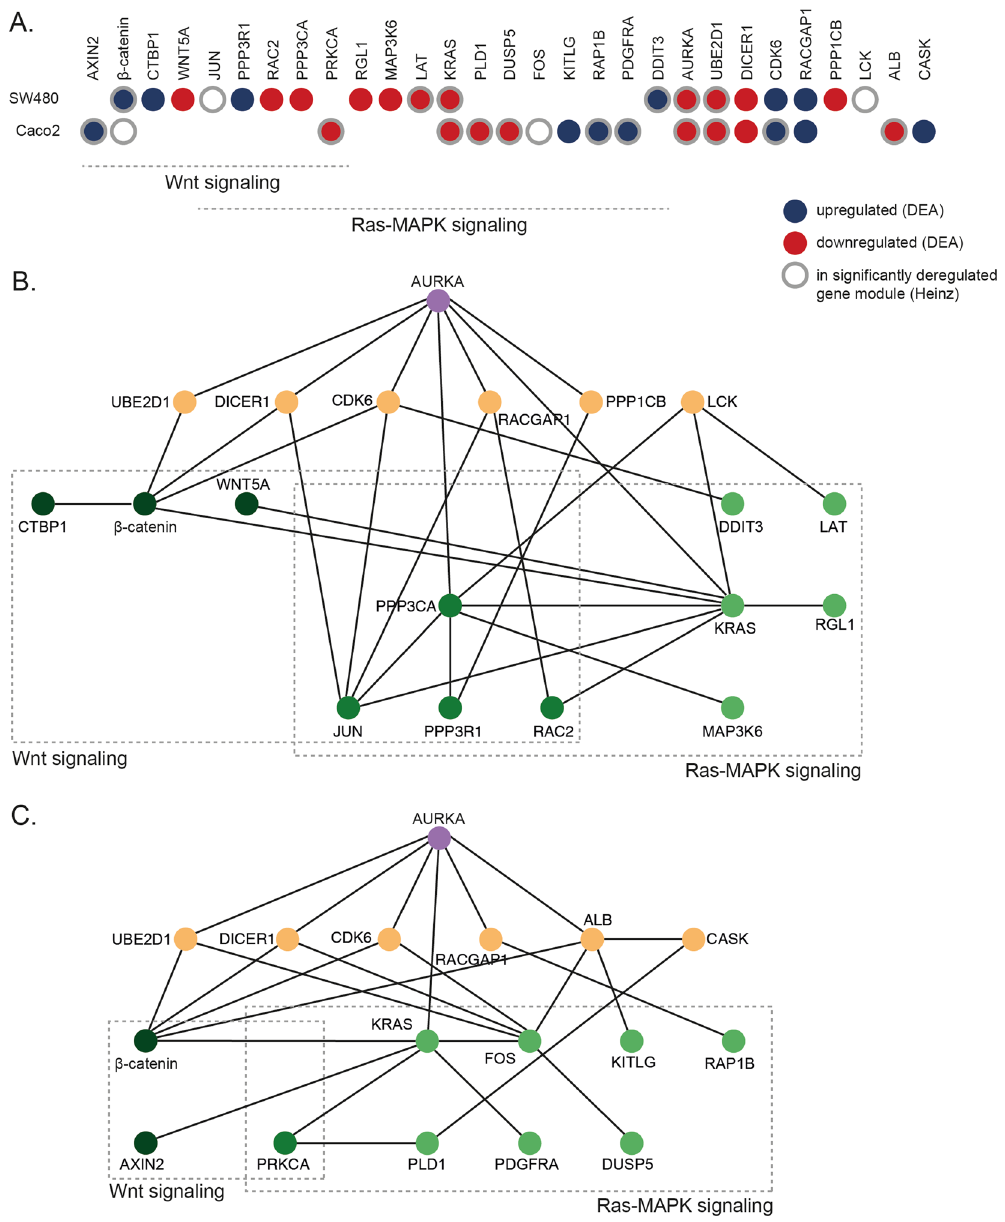
Figure 3. Wnt and Ras-MAPK pathway genes and interacting genes with AURKA, significantly deregulated (DEA) or in the most significantly deregulated gene module (Heinz) in the two cell lines, SW480 and Caco2. ( A ) Overview of AURKA, the genes in the Wnt and Ras-MAPK pathways, and the genes connecting these, either significantly deregulated (DEA; q-value < 0.05, red for down and blue for upregulation) or found in the most significantly deregulated gene module (Heinz, grey edges) in the two cell lines. ( B ) and ( C ) Interactions between AURKA (top-middle, purple) and the Wnt and Ras-MAPK signalling genes (green shades) deduced together with additional ‘connecting genes’ (orange) using a shortest path analysis in SW480 ( B ) and Caco2 ( C